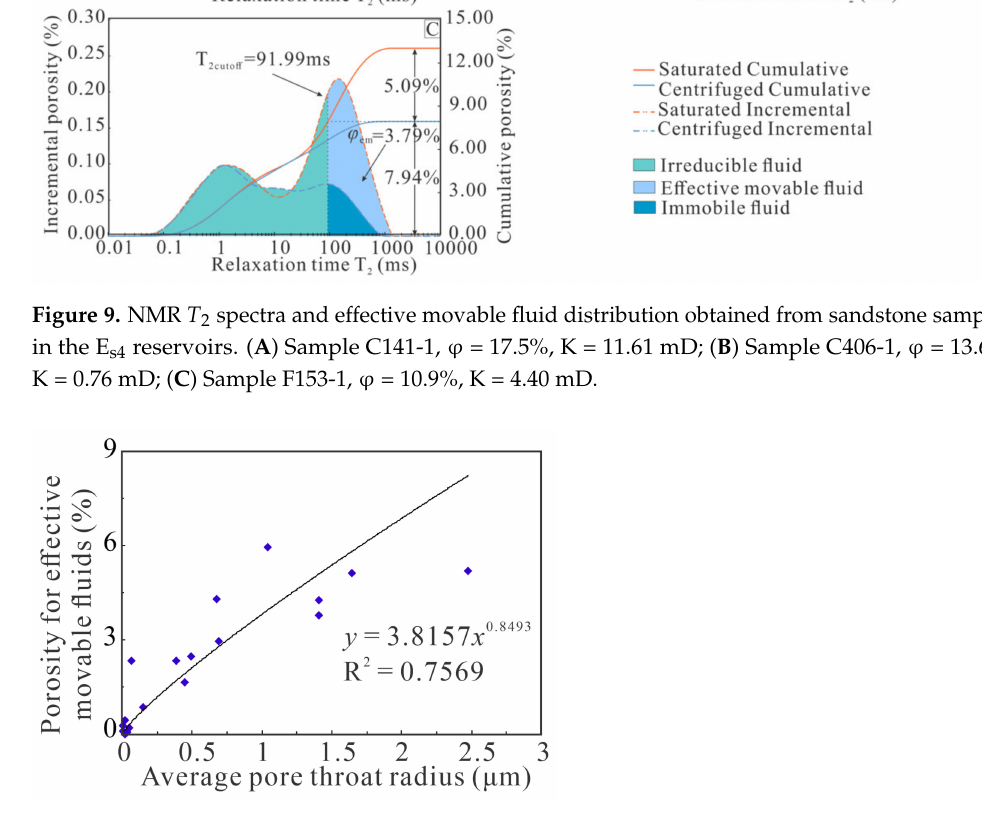
Figure 10. Relationship between porosity for effective movable fluids and average pore throat radius.